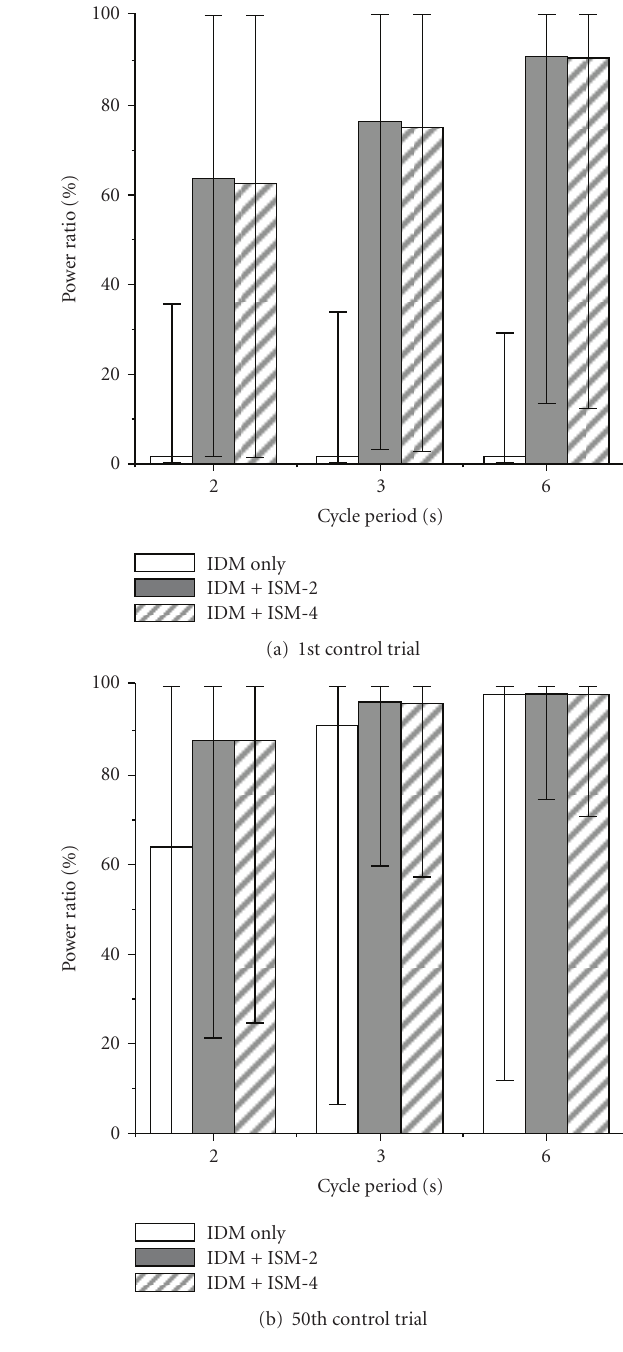
Figure 9: Average values of the power ratio (PR) in tracking control by FEL-FES controllers. Error bar shows the minimum and the maximum values of the